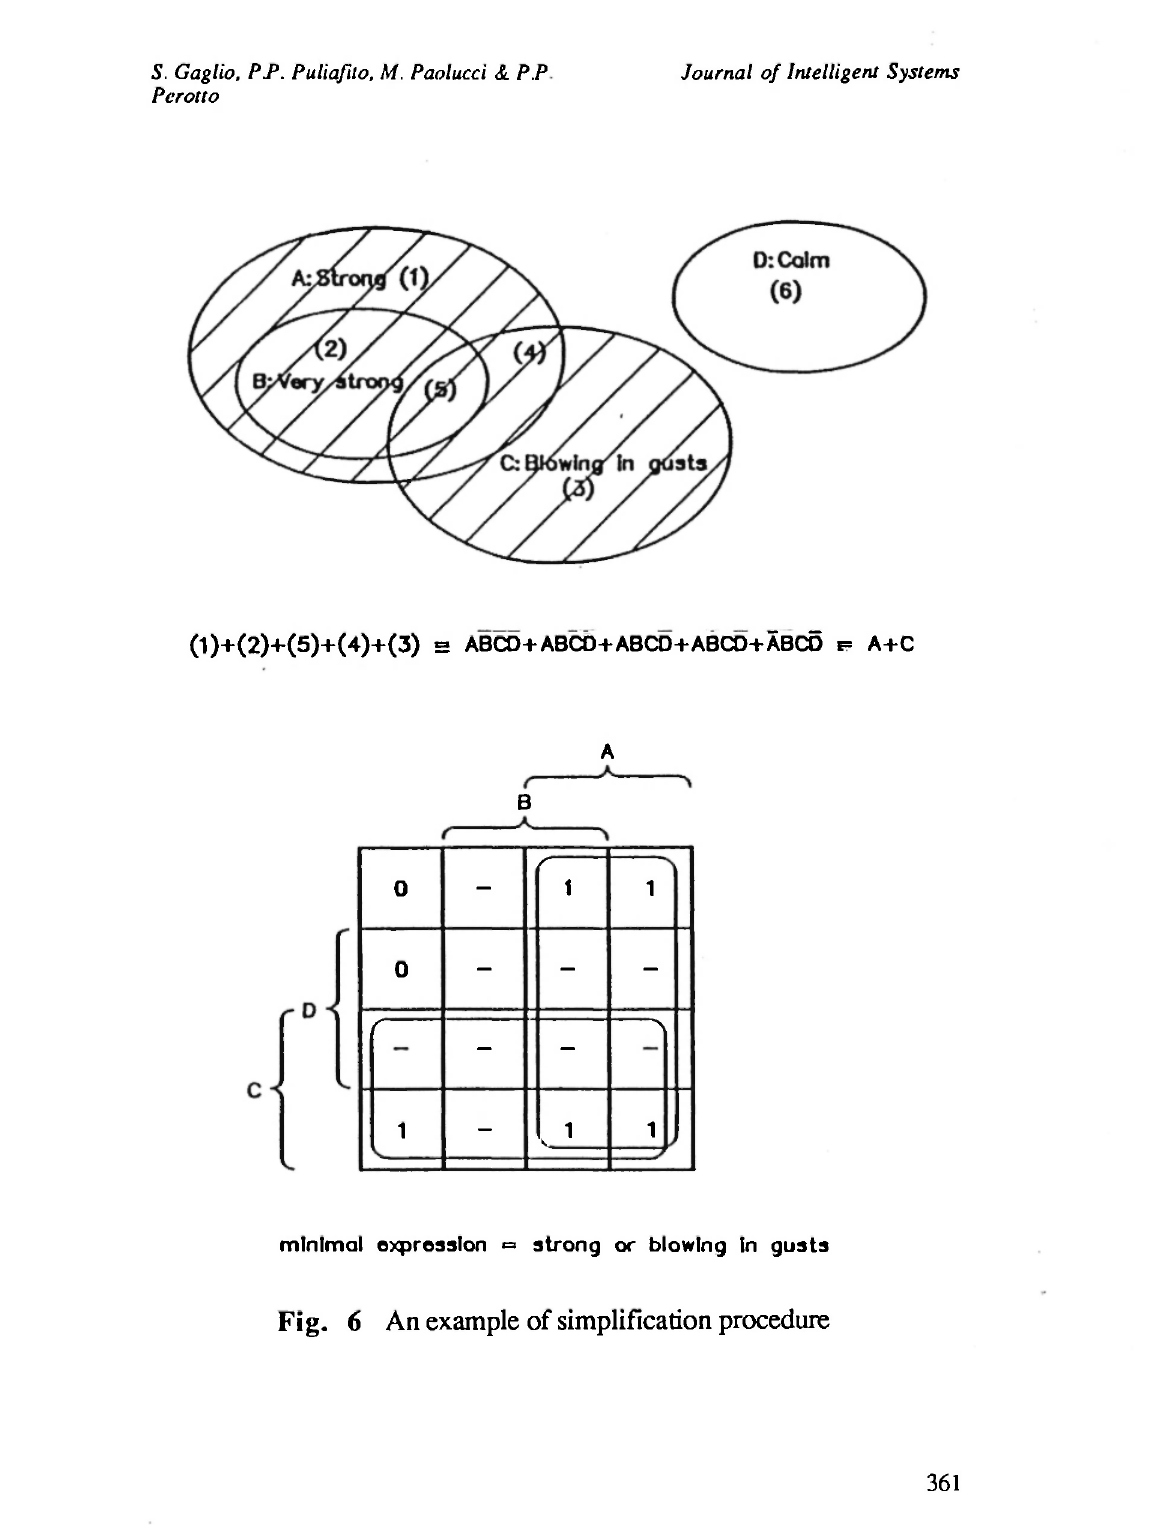
Fig. 6 An example of simplification